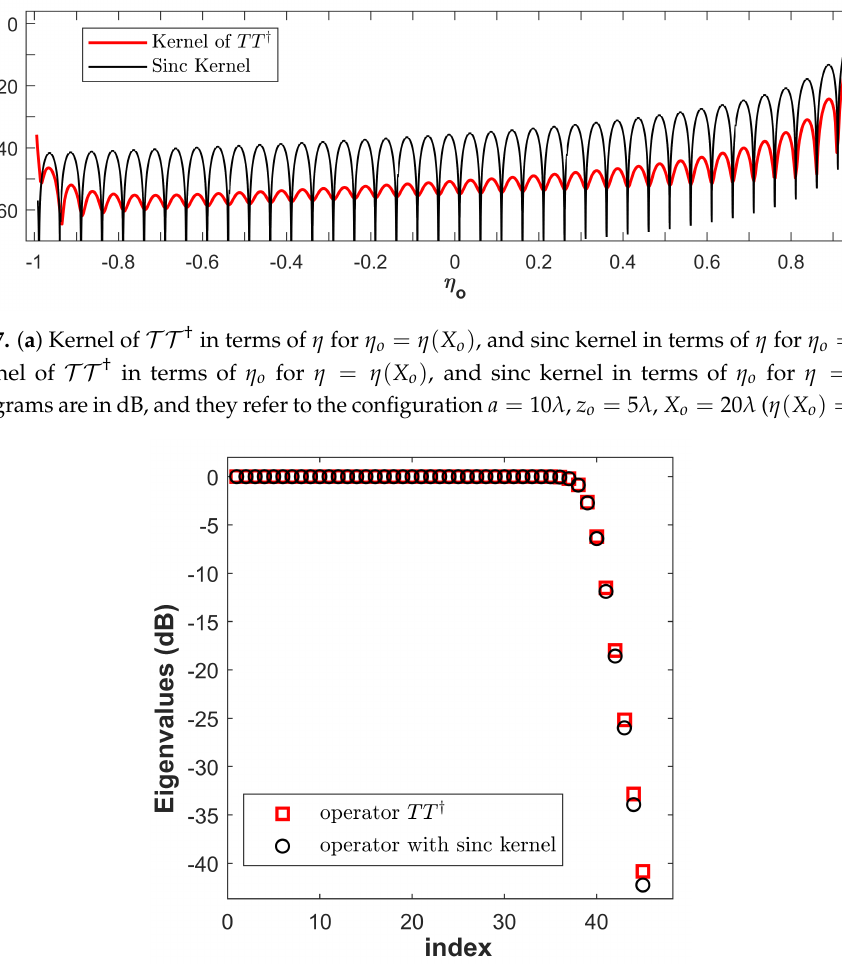
Figure 8. Eigenvalues of the operator T T † , and eigenvalues of the sinc kernel. The diagrams refer to the configuration a = 10 λ , z o = 5 λ , X o = 20 λ ( η ( X o ) =